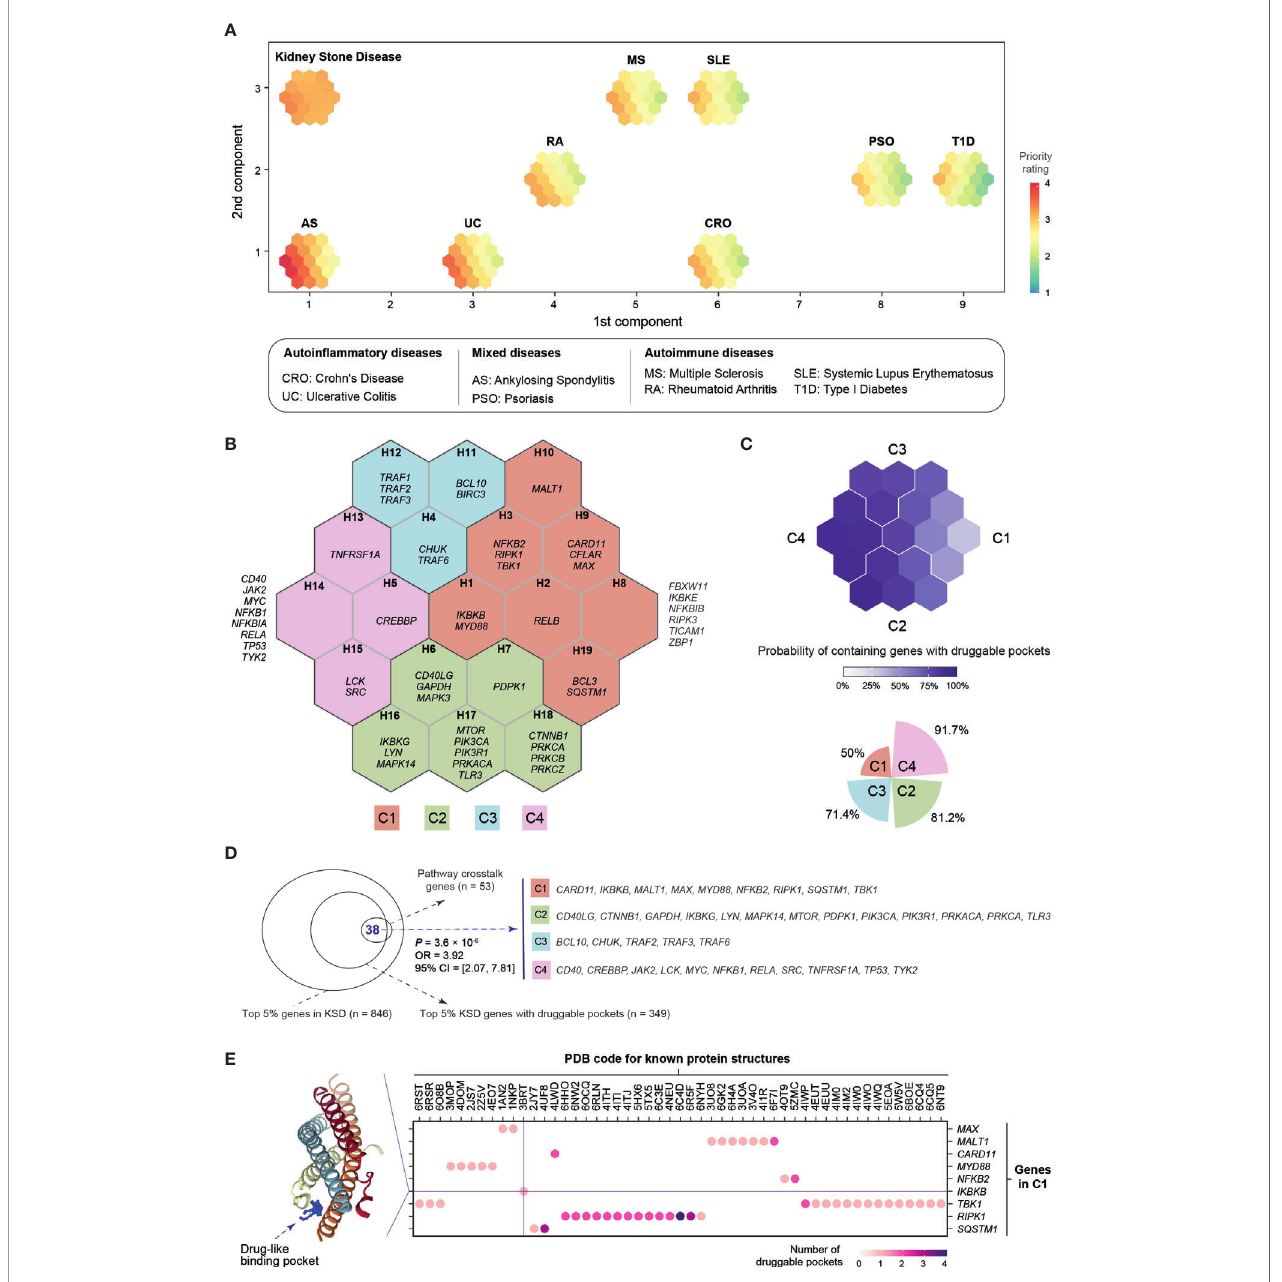
FIGURE 5 | Cross-disease analysis of pathway crosstalk genes. The target prioritizations for eight immune-related disease traits are sourced from the Pi database. On the basis of degree of autoin fl ammation versus autoimmunity, these immune traits are grouped into polygenic autoin fl ammatory diseases (CRO and UC), polygenic autoimmune diseases (MS, RA, SLE and T1D), and mixed diseases having both (AS and PSO). (A) Comparisons using the supra-hexagonal map. This map was learned from the prioritization information of 53 crosstalk genes in kidney stone disease (KSD) and eight immune-related traits. Each map illustrates a trait- speci fi c crosstalk gene prioritization pro fi le. Across traits, genes with similar prioritization patterns are mapped onto the same or nearly position in the map. The outermost frame represents the landscape for the traits analyzed, from which geometric locations of traits delineate their relationships (by the similarity of prioritization pro fi les between traits). (B) Gene clusters. The map was divided into four target gene clusters (C1 – C4) as color coded; each covering continuous hexagons. Hexagons are indexed and expanded outward (H1 – H19). Also displayed are genes found in each hexagon. (C) Tractability. The map is color-coded by the probability of each hexagon containing tractable genes, with the percentage of tractable genes summarized for each cluster shown beneath (polar bar). A gene is de fi ned as being tractable if predicted to contain a druggable pocket. (D) Venn diagram illustrating the enrichment for tractable genes. The signi fi cance level (P), odds ratio (OR), and 95% con fi dence intervals (CI) calculated using one-sided Fisher ’ s exact test. KSD, kidney stone disease. (E) Druggable pockets. Dot plot shows nine tractable genes in C1 ( y -axis) and their PDB known protein structures ( x -axis). Color-coded is the number of druggable pockets predicted in the structure. An example structure “ 3BRT ” is visualized on the left, with a druggable pocket illustrated using 3D balls in